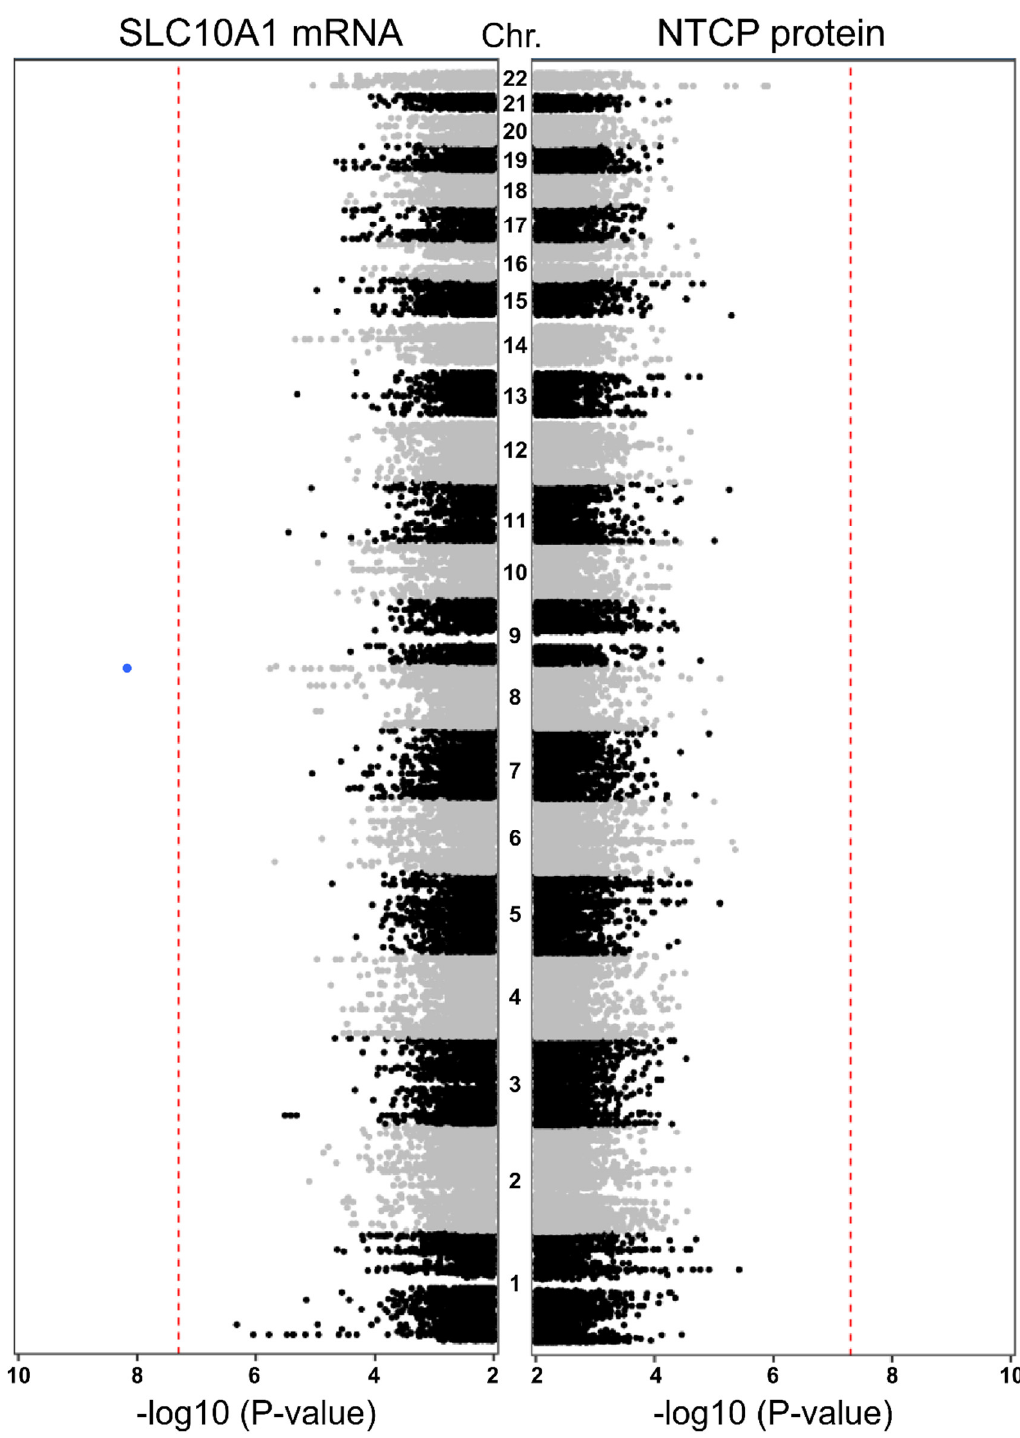
Figure 4. Genome-wide association analyses of genetic variants and SLC10A1 /NTCP expression. Manhattan plots show the association of –log10-transformed p -values of genome-wide association analysis on SLC10A1 mRNA ( left ) and NTCP protein level ( right ) across the 22 autosomes (from bottom [chr1] to top [chr22]) in the 143 liver samples. Red lines indicate the genome-wide significance level of p -value = 5 × 10 −8 .